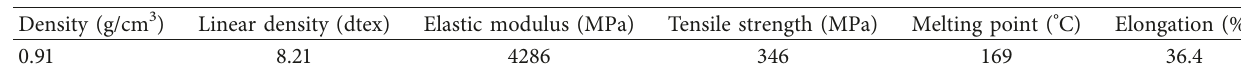
Table 3: Glass fiber